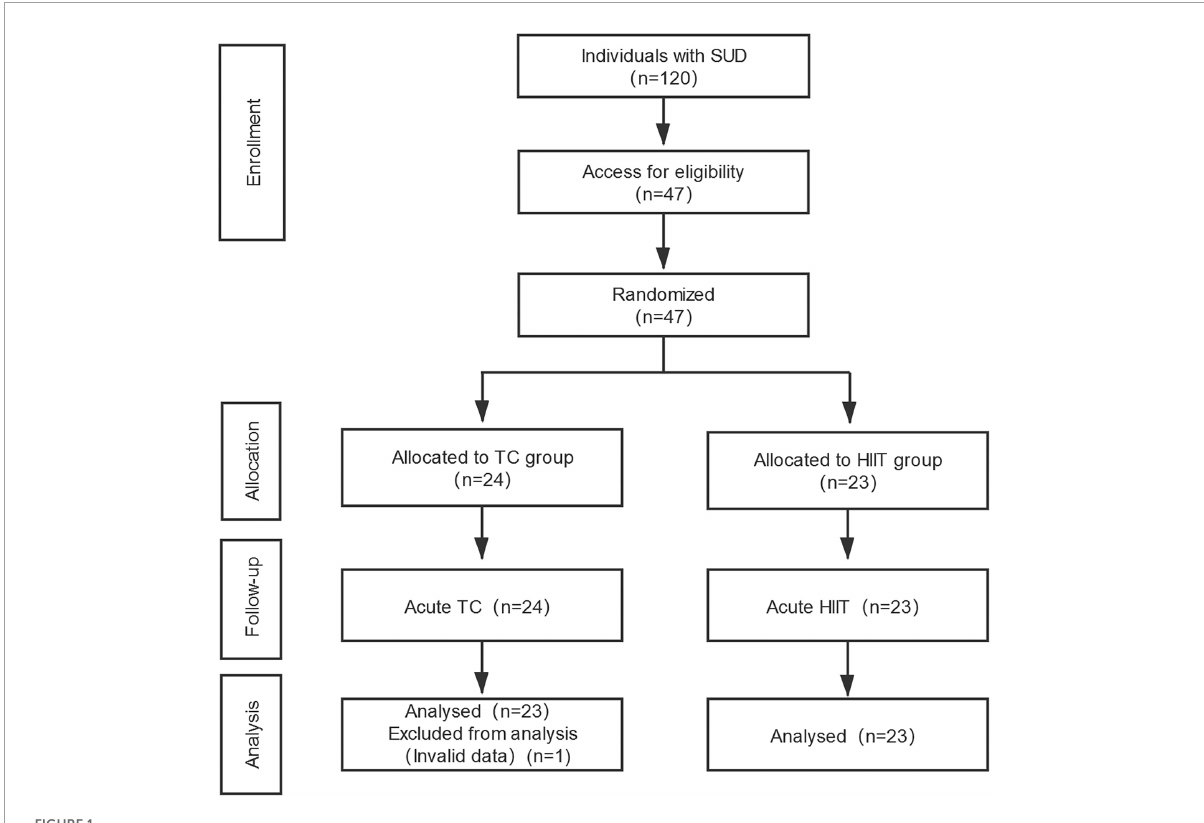
FIGURE1 Flow diagram of the intervention process of the two groups.